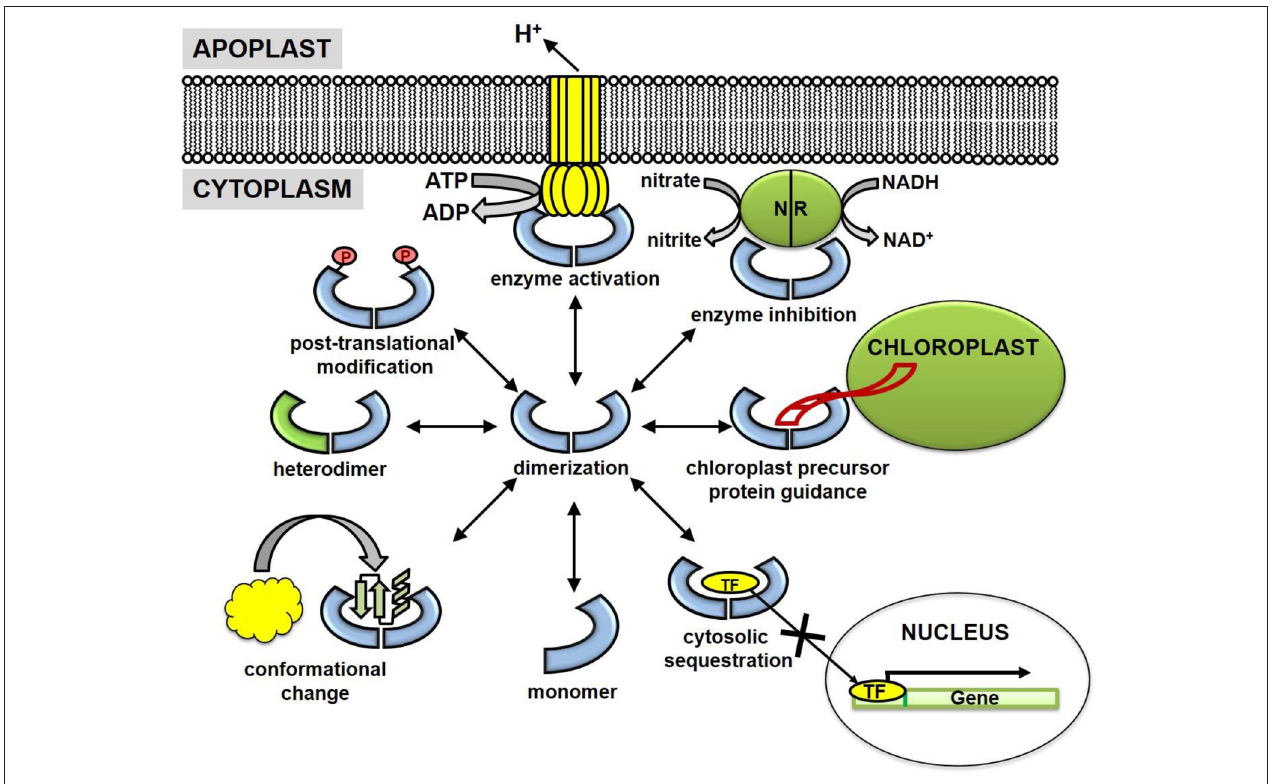
FIGURE 2 | Cellular mechanisms of plant 14-3-3 proteins. 14-3-3 proteins are generally believed to function as dimers (hetero- and homo-dimers), although evidence also supports a functional role for 14-3-3 monomers. Several key 14-3-3 mechanisms are enzyme activation, enzyme inhibition, chloroplast precursor protein guidance, cytosolic sequestration, and conformational changes of binding partners. Post-translational modifications (PTMs) of 14-3-3 proteins (phosphorylation, acetylation, ubiquitination) have been identified but lack the functional characterization. NR, nitrate reductase and TF, transcription